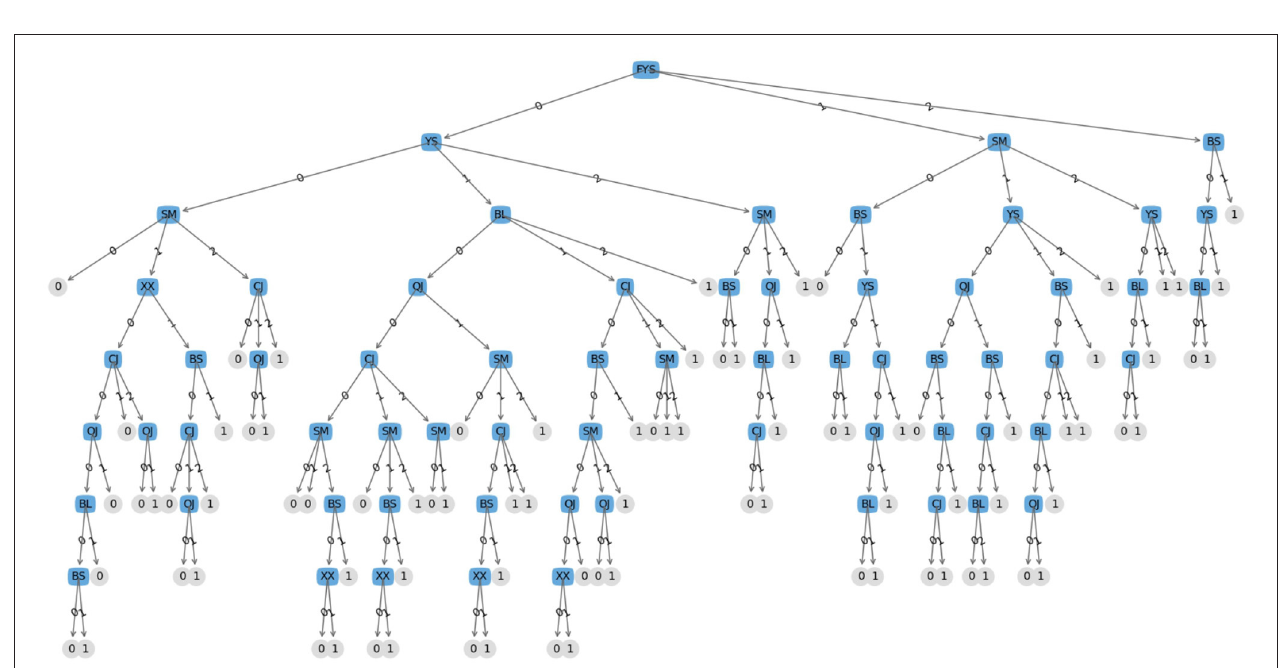
FIGURE 5 | Decision tree model